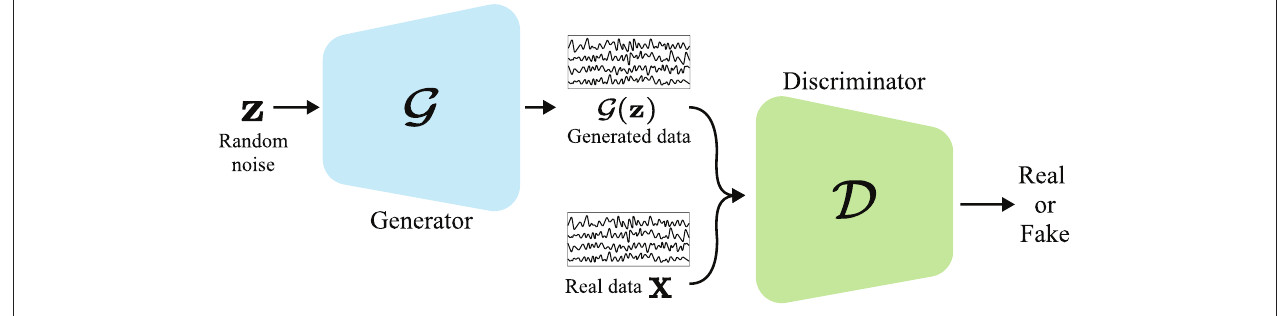
FIGURE 5 | Illustration of generative adversarial network (GAN) (Goodfellow et al., 2014). Generator G outputs generated data G ( z ) using a random noise vector z . Then, discriminator D distinguishes generated data G ( z ) from real data x